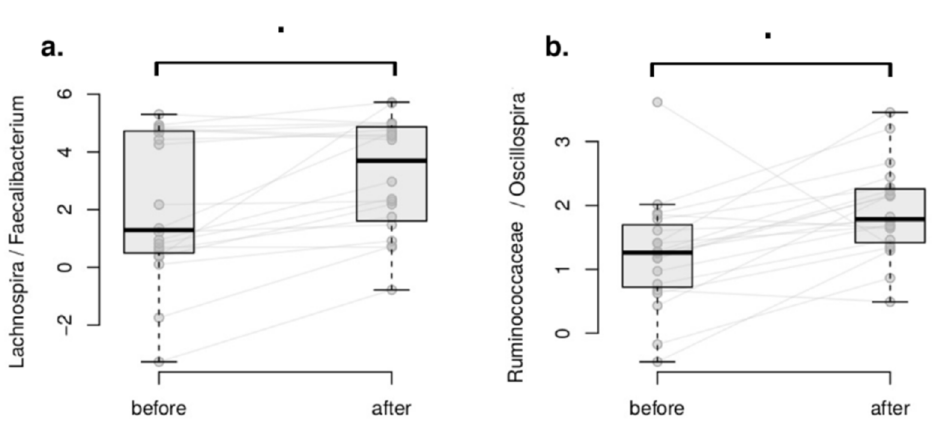
Figure 4. Within-group differential abundance analysis using DBA. Microbial balances associ- ated with the plant-based intervention. ( a ) Lachnospira / Faecalibacterium balance. ( b ) Ruminococ- caceae / Oscillospira balance. Dots denote associations very close to significance (FDR <